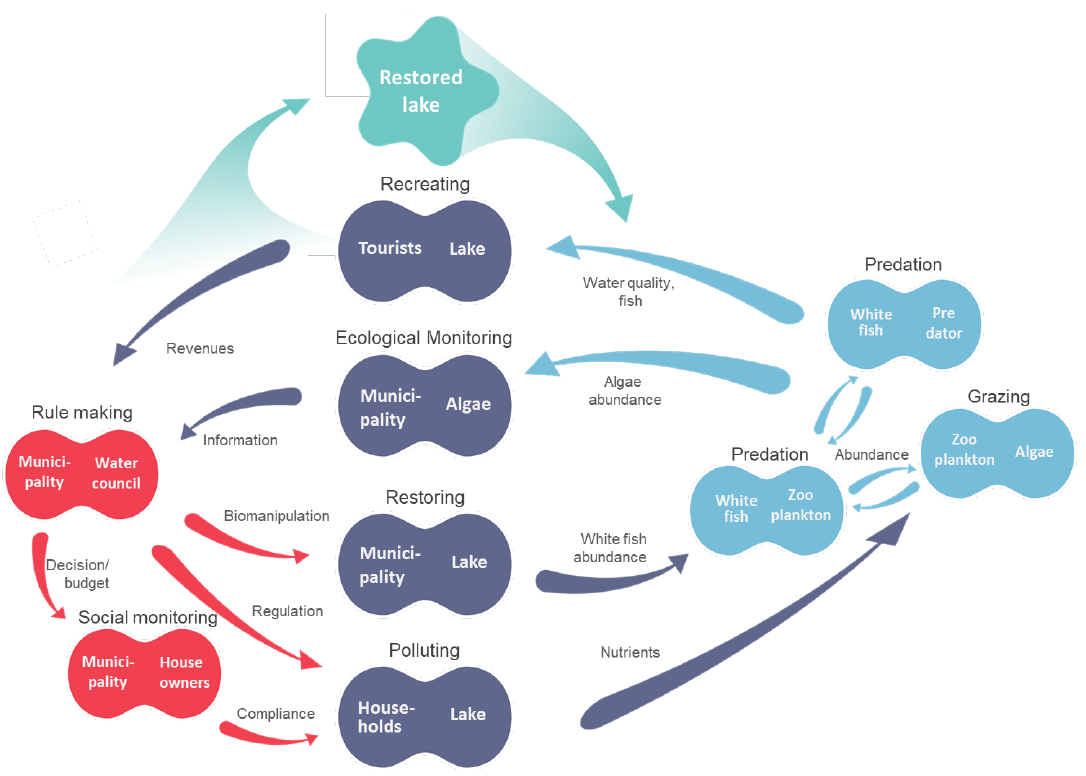
Figure A2: SE-AS representation of the configuration of social-ecological (dark blue), social (red), and ecological action situations (light blue) hypothesized to influence the success of restoration of the turbid lake